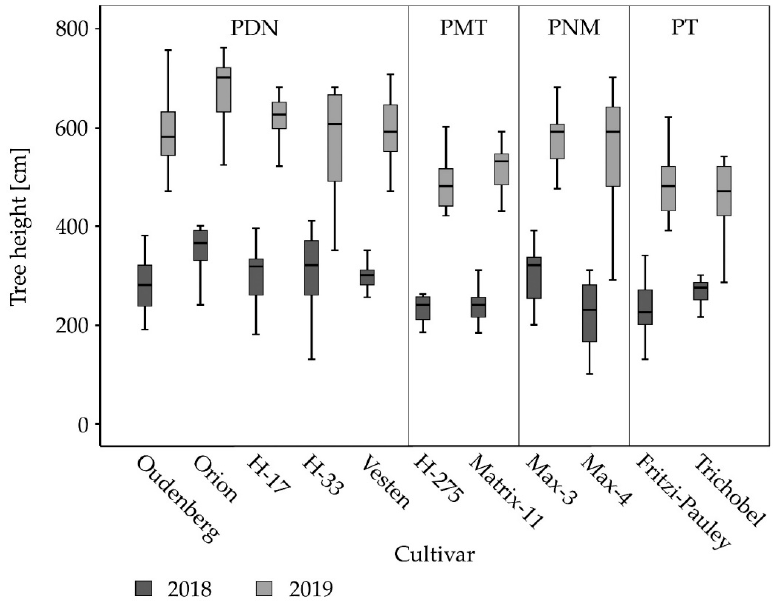
Figure 2. Box plots of tree heights in Bishkek I at the end of the growing seasons 2018 (dark grey) and 2019 (light grey). Parentages: PDN— P. deltoides x nigra , PMT— P. maximoviczii x trichocarpa , PNM— P.